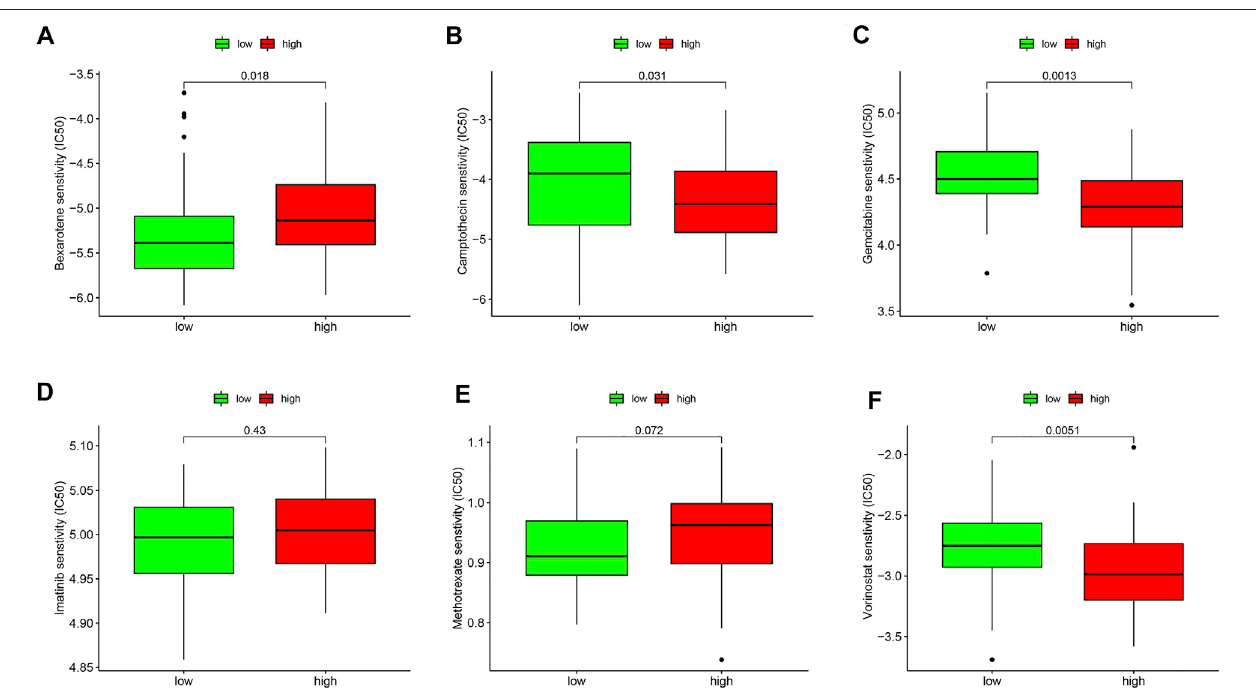
FIGURE 10 | Validation of drug sensitivity analysis in the GEO database. Box plots demonstrate the estimated IC50 values of bexarotene (A) , camptothecin (B) , gemcitabine (C) , imatinib (D) , methotrexate (E), and vorinostat (F) . The lower the IC50 value, the higher is the sensitivity to the